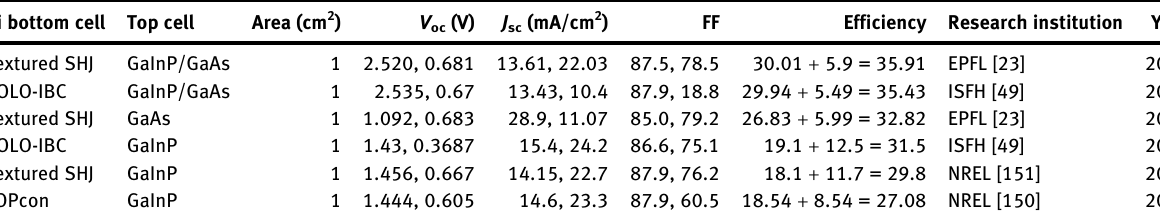
Textured SHJ TOPcon